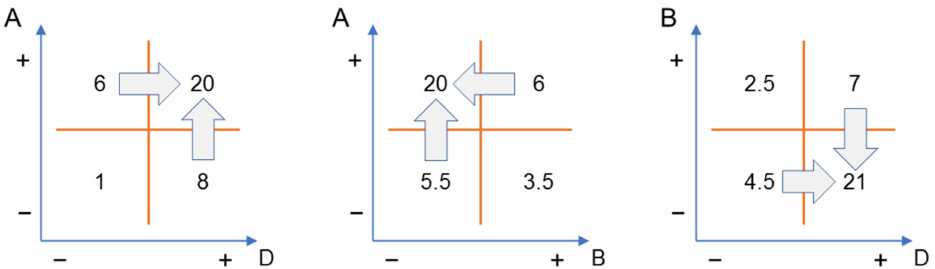
Figure A2. The matrices show the mean values of the yields obtained at the different levels of the factors, considered two by two. The “ − “ and “+” symbols represent the lowest and the highest values of the factors (A = H 2 O 2 /Pt mole ratio, B = temperature, D = reaction time), respectively. The arrows point towards the higher yields, indicating the best level for the